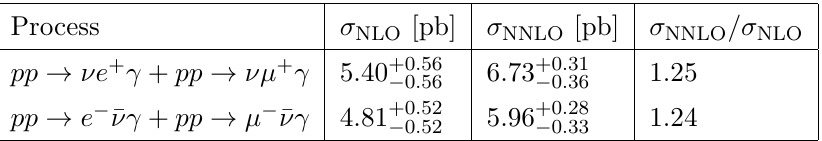
√ s = 13 TeV using cuts of table 8 and the isolation cuts , given without an uncertainty, indicates that the NNLO /σ NLO